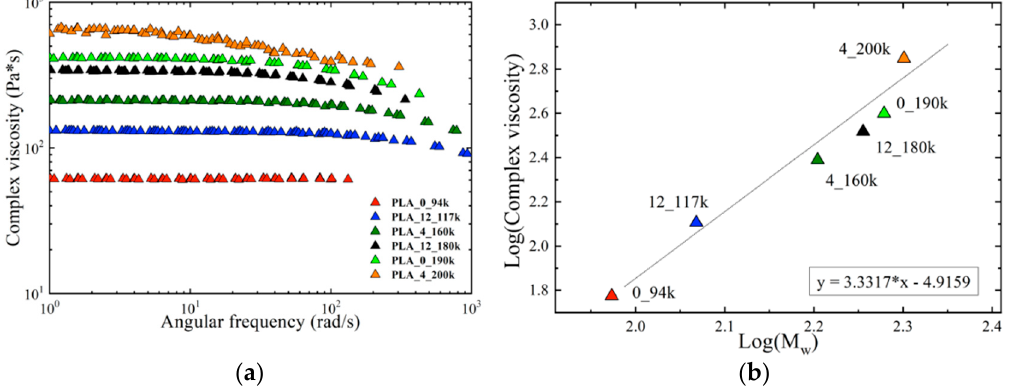
Figure 2. ( a ) Complex viscosity obtained with temperature–time superposition analysis at the reference temperature of 190 °C as a function of the angular frequency for all materials; ( b ) logarithm of the Newtonian viscosity as a function of the logarithm of molar mass for all the materials. The angular coefficient of the trend line confirms that the molar mass is the main parameter that influences the viscosity.